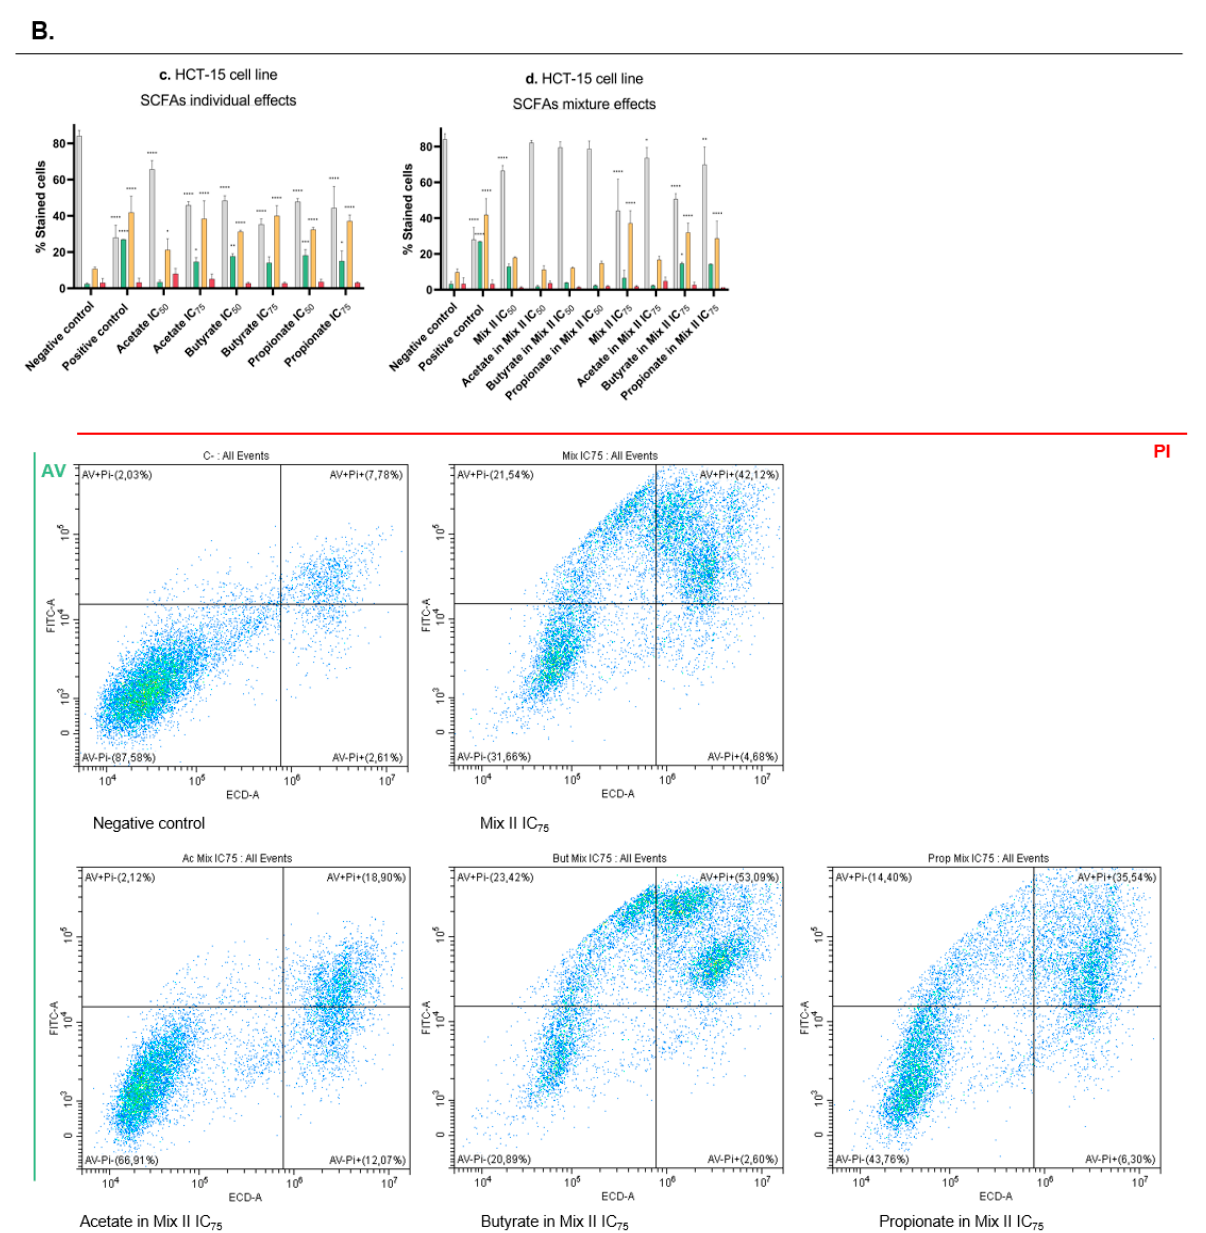
Figure 5. Apoptotic cell-death effects induced by SCFAs, individually or in mixture, in RKO ( A ) and HCT-15 ( B ) cells. ( a – d ) Cell-survival analysis by CFA assay in CRC cells treated with each SCFA, individually or in mixture, for 48 h. ( a ) RKO cells were incubated with the IC 50 and the IC 75 of each SCFA (81.04 and 116.60 mM of acetate, 10.84 and 44.16 mM of butyrate, 32.25 and 56.89 mM of propionate). ( b ) RKO cells were incubated with the IC 50 and the IC 75 of the mixture II, as well as the correspondent concentrations of each SCFA in that mixture (47.61 mM of Mix II containing 28.57 mM of acetate, 7.14 mM of butyrate, and 11.90 mM of propionate; 77.32 mM of Mix II containing 46.39 mM of acetate, 11.60 mM of butyrate, and 19.33 mM of propionate). ( c ) HCT-15 cells were incubated with the IC 50 and the IC 75 of each SCFA (89.52 and 161.55 mM of acetate, 4.57 and 14.56 mM of butyrate, 22.70 and 50.70 mM of propionate). ( d ) HCT-15 cells were incubated with the IC 50 and the IC 75 of the mixture II, as well as the correspondent concentrations of each SCFA in that mixture (13.67 mM of Mix II containing 8.20 mM of acetate, 2.05 mM of butyrate, and 3.42 mM of propionate; 39.97 mM of Mix II containing 23.98 mM of acetate, 6.00 mM of butyrate, and 9.99 mM of propionate). Cells were incubated with fresh complete medium as negative control and with 0.2 µ M of staurosporin